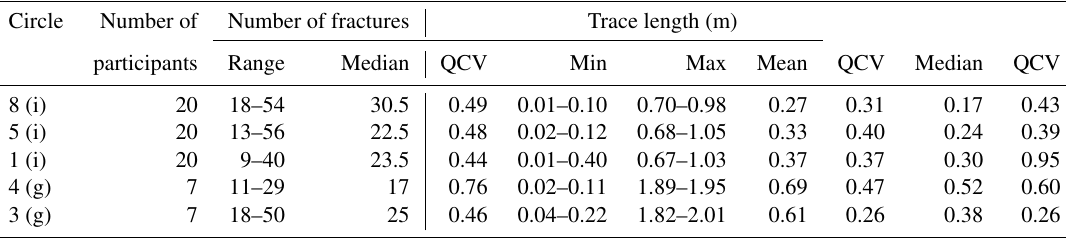
Table 6. Summary of fracture parameters reported for window sampling. Data are presented in the order the scanlines were undertaken within the workshops. The labels (i) and (g) denote whether the scanline was undertaken individually or as a group. Circle Number of Number of fractures Trace length (m) participants Range Median QCV Min Mean QCV Median